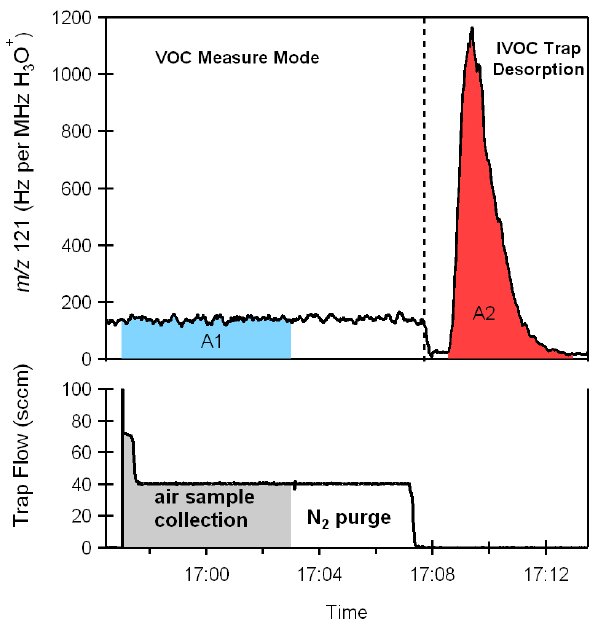
Fig. 7. Upper panel shows a time series of the 1,3,5- trimethylbenzene ion signal ( m/z 121) from a prepared test mixture as measured in VOC mode passing through the water trap and from desorption of a 257cc air sample of the test mixture collected on the Tenax trap (A2 red shading). The bottom panel shows the gas flow through the Tenax trap. The shaded area A1 in VOC mode corresponds to the IVOC sample collection